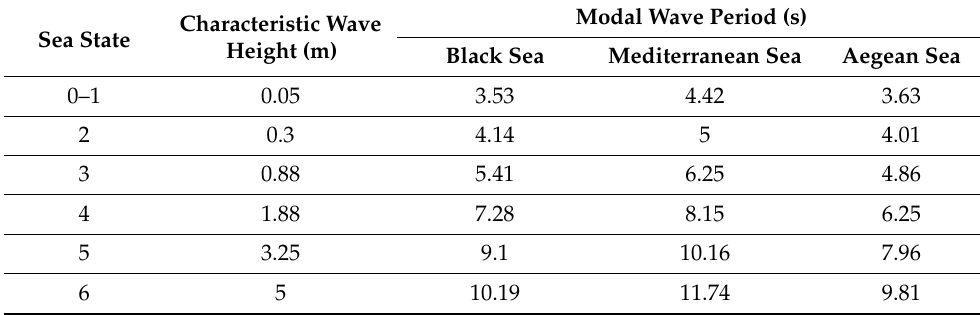
Table 1. Characteristic wave heights and modal wave periods used for the study [23].